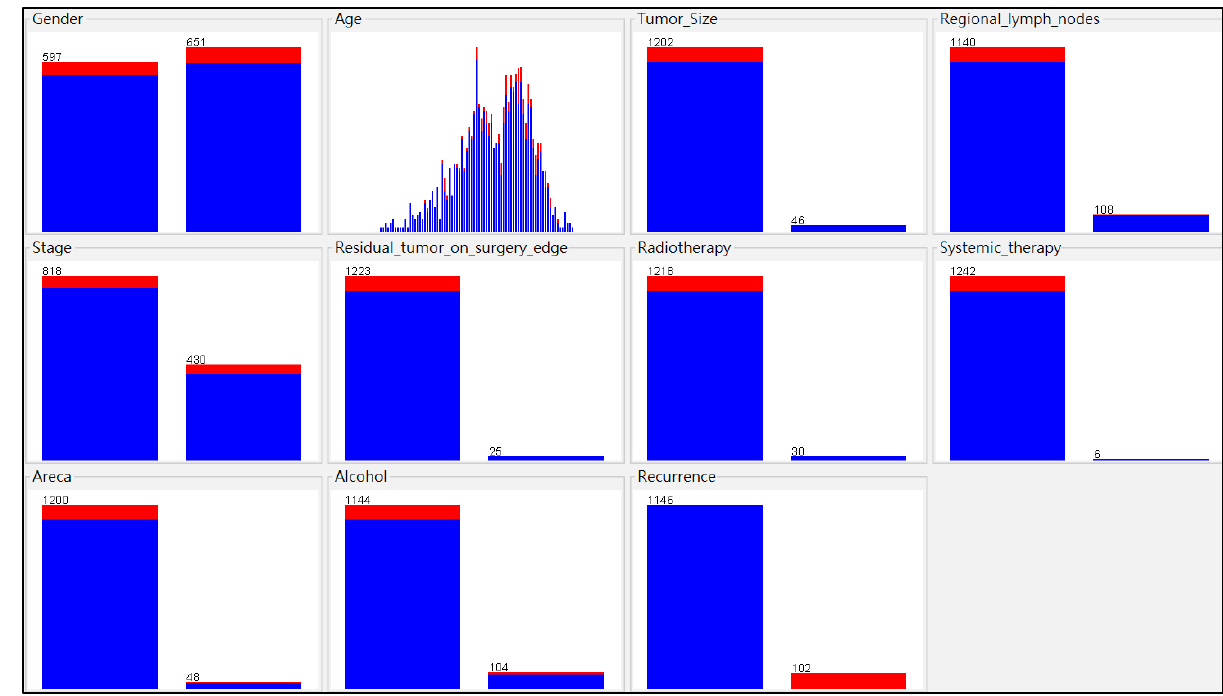
Figure 2. Sample distribution of each characteristic specific to SPSC (red: SPSC; blue: non-SPSC).